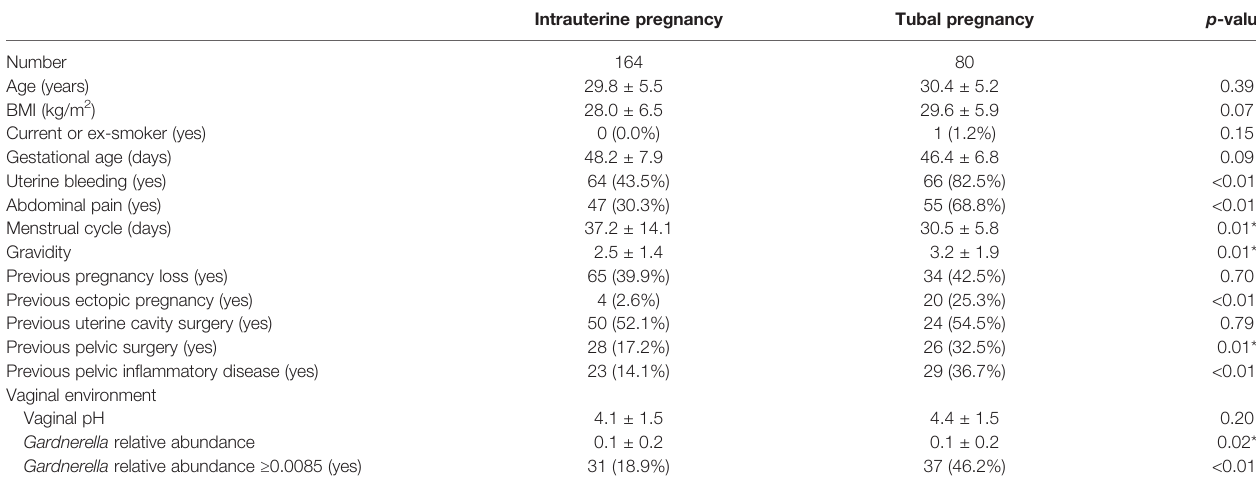
TABLE 1 | Participant baseline